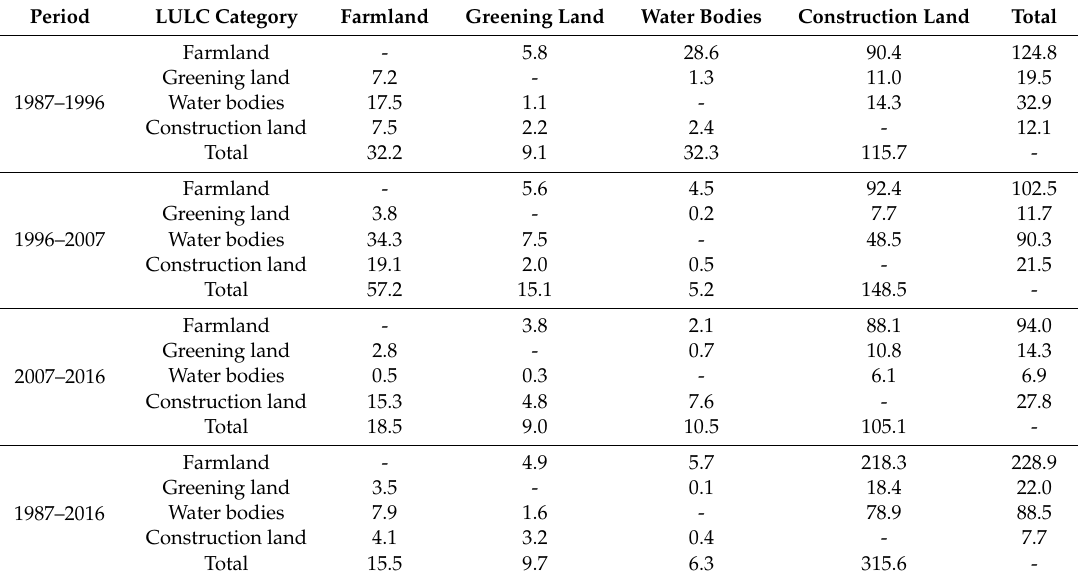
Table 7. Transfer matrix among di ff erent LULC categories during 1987–2016 in Wuhan (km 2 ). Period LULC Category